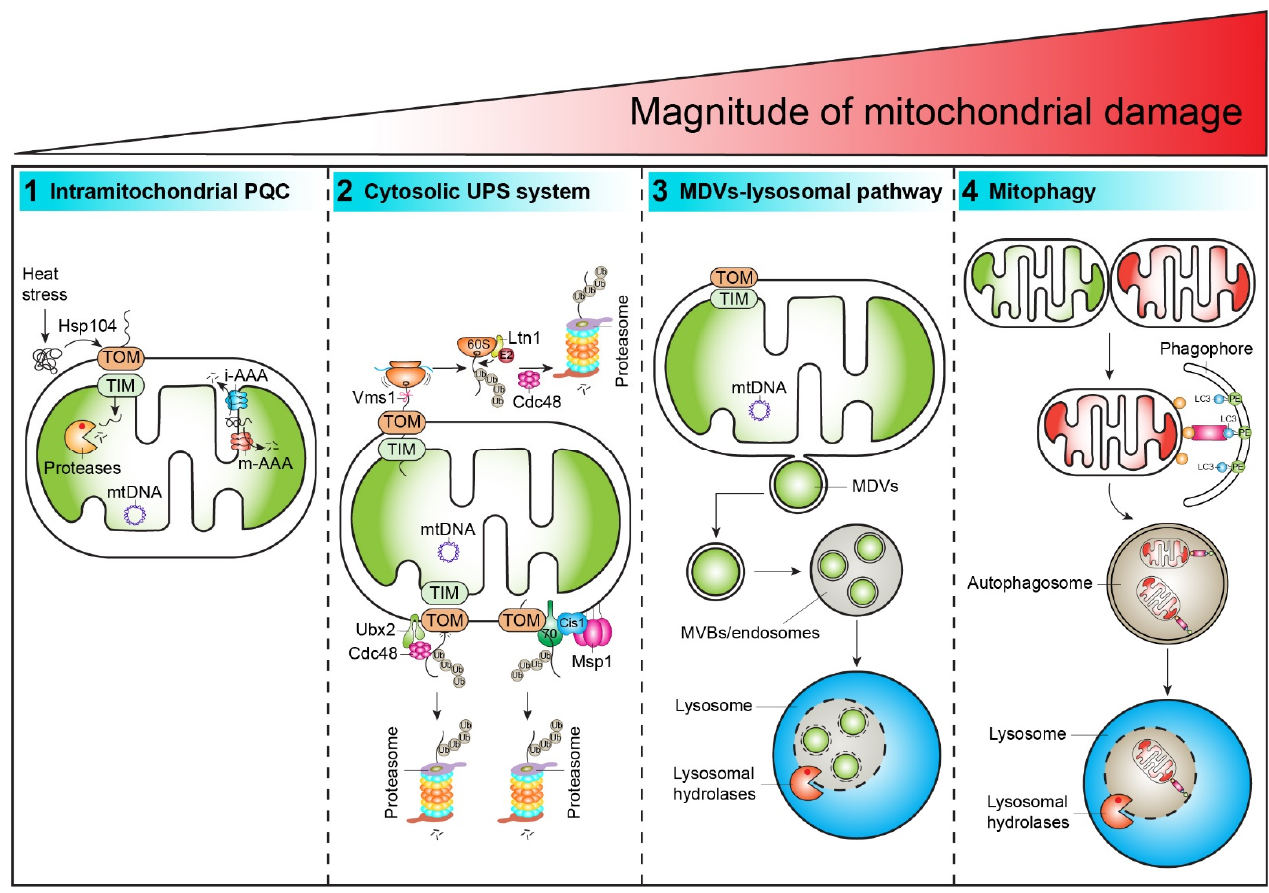
Figure 1. Mitochondrial quality control pathways. In response to moderate mitochondrial damage, misfolded or damaged proteins are initially degraded by the mitochondrial protease–chaperone network ( 1 ). The inner mitochondrial membrane- localized AAA + metalloproteases (i-AAA and m-AAA) and the mitochondrial matrix localized ATP-dependent Lon (Pim1 in yeast) protease are main players removing misfolded/damaged proteins. Heat stress-induced aggregation-prone cytosolic proteins are partly imported into mitochondria for degradation in a Hsp104-dependent disaggregation manner. Stalled mitochondrial precursor proteins are degraded via distinct pathways following ubiquitination and proteasomal degradation ( 2 ). These cytosolic ubiquitin-proteasome system (UPS) pathways prevent an accumulation of stalled precursors on the organelle’s surface, safeguarding the translocation channel from being clogged, and thus restore full protein import capacity. Upon mild/local mitochondrial oxidative damage, mitochondrial-derived vesicles (MDVs) are generated that are degraded in the lysosome ( 3 ). In response to severe mitochondrial damage or when other quality control pathways fail, the entire organelle is selectively removed via mitophagy at the cellular level ( 4 ). All levels of mitochondrial quality control presumably occur in parallel, yet the exact interplay and regulation is a matter of current